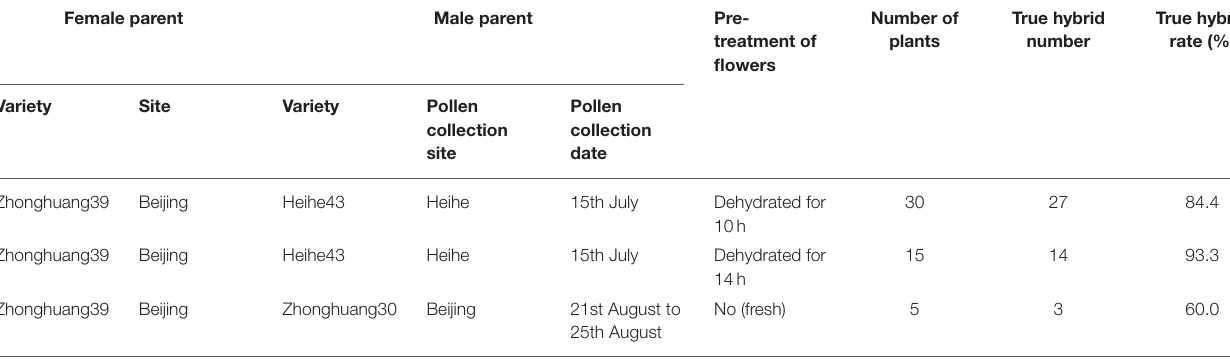
TABLE 1 | Effects of preserved pollen on off-site pollination in Beijing. Female parent Male parent Pre- Variety Site Variety Pollen